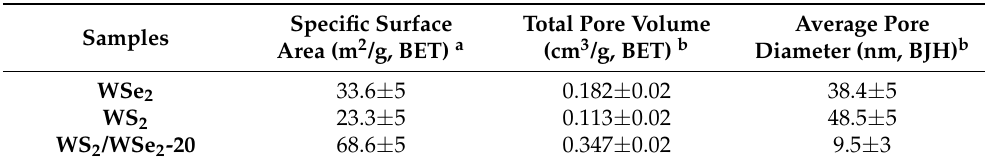
Table 1. The physical adsorption factors of the photocatalysts of WS 2 , WSe 2 , and WS 2 /WSe 2 -20 were measured three